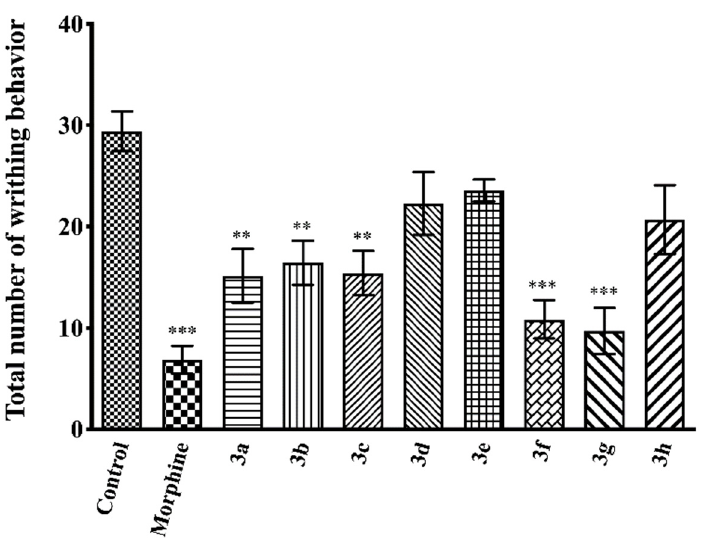
Figure 5. Effects of test compounds 3a – 3h (50 mg/kg, p.o., administered 60 min before testing) and morphine (10 mg/kg, i.p., administered 30 min before testing) on the number of writhing behaviors of mice in the acetic acid-induced writhing test. Significance against control group ** p < 0.01, *** p < 0.001. Values are mean ± SEM. One-way ANOVA and post-hoc Tukey’s test, n = 7.